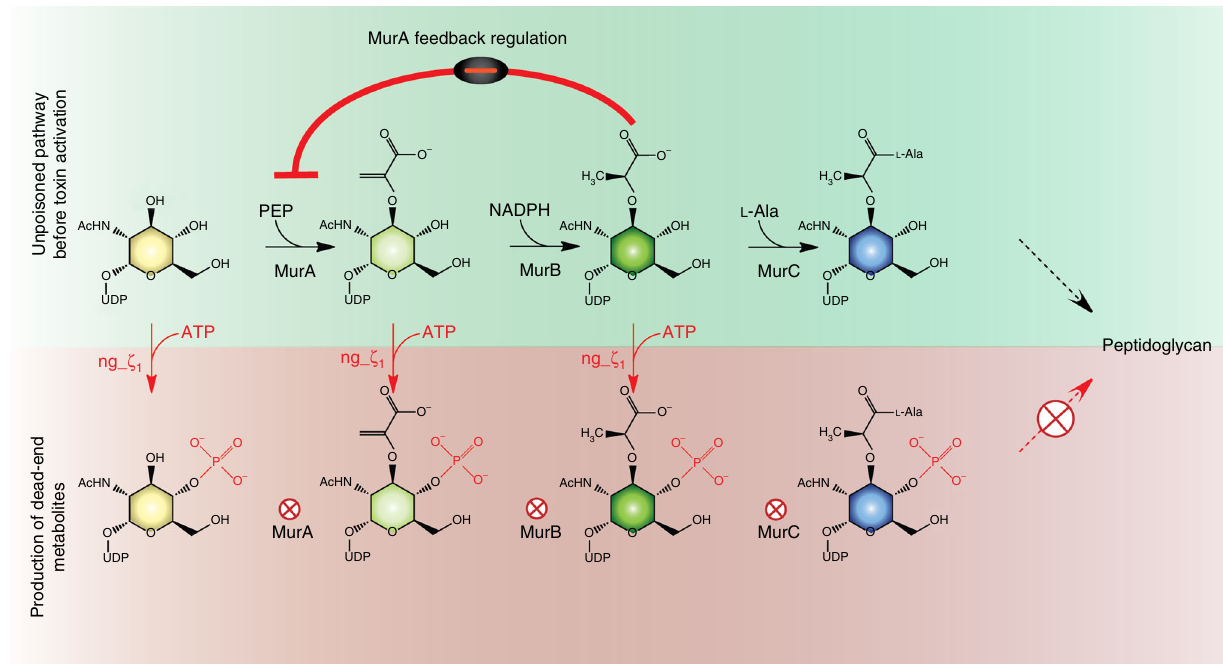
Fig. 5 ng ζ _1 drains precursors from peptidoglycan synthesis at multiple stages. Under normal conditions cytosolic levels of UNAM regulate peptidoglycan synthesis by a negative feedback loop inhibiting MurA. In contrast, once ng ζ _1 becomes active, MurA, MurB, and MurC are depleted from their substrates. All phosphorylated precursors are dead-end metabolites; however, none of them seems to directly inhibit any enzyme of early peptidoglycan